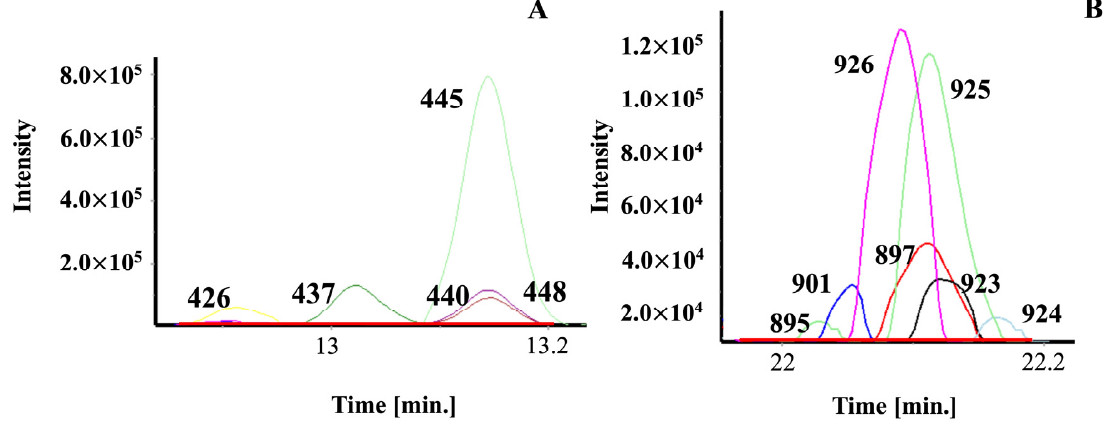
Figure 3. Illustrative examples of spectral deconvolution and MS subtraction using the GC-GC/MS database as target compounds. Each panel displays a portion of a 1D GC (RTX-5MS column)/MS analysis. ( A ) peak ID’s and heartcuts time (RTX-WAX): 426 = 1-methylethenyl-pyrazine, 20–21